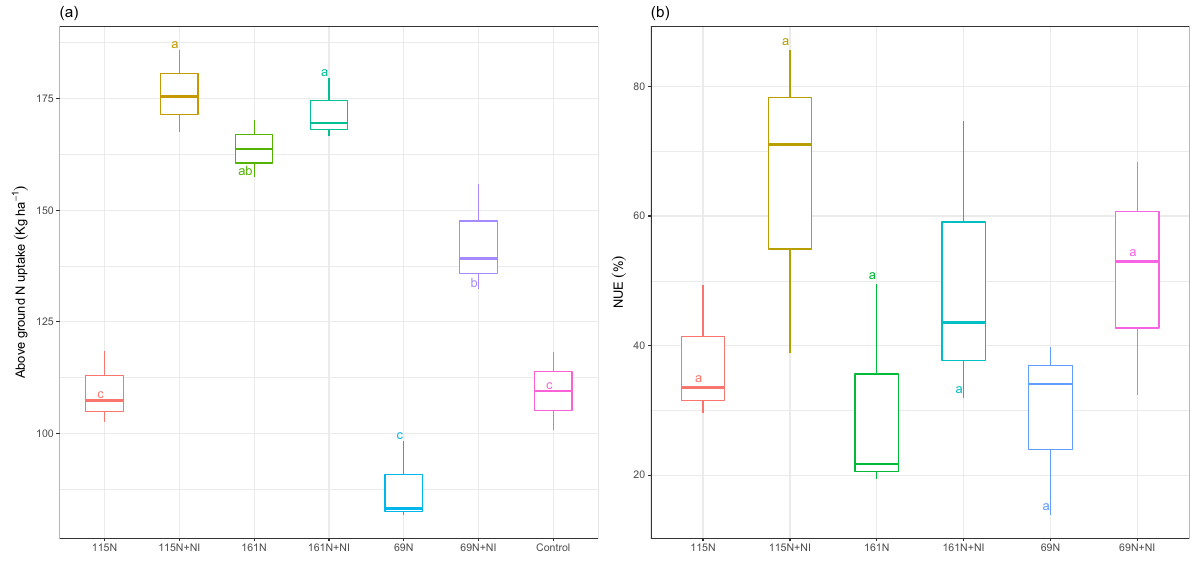
Figure 4. Above-ground N uptake ( a ) and nitrogen use efficiency (NUE) ( b ) of maize at the different levels of N application and with or without NI during the maize growth season in 2018. Means with the same letters are not significantly different according to the least significant difference (LSD) at p < 0.01, n = 3.